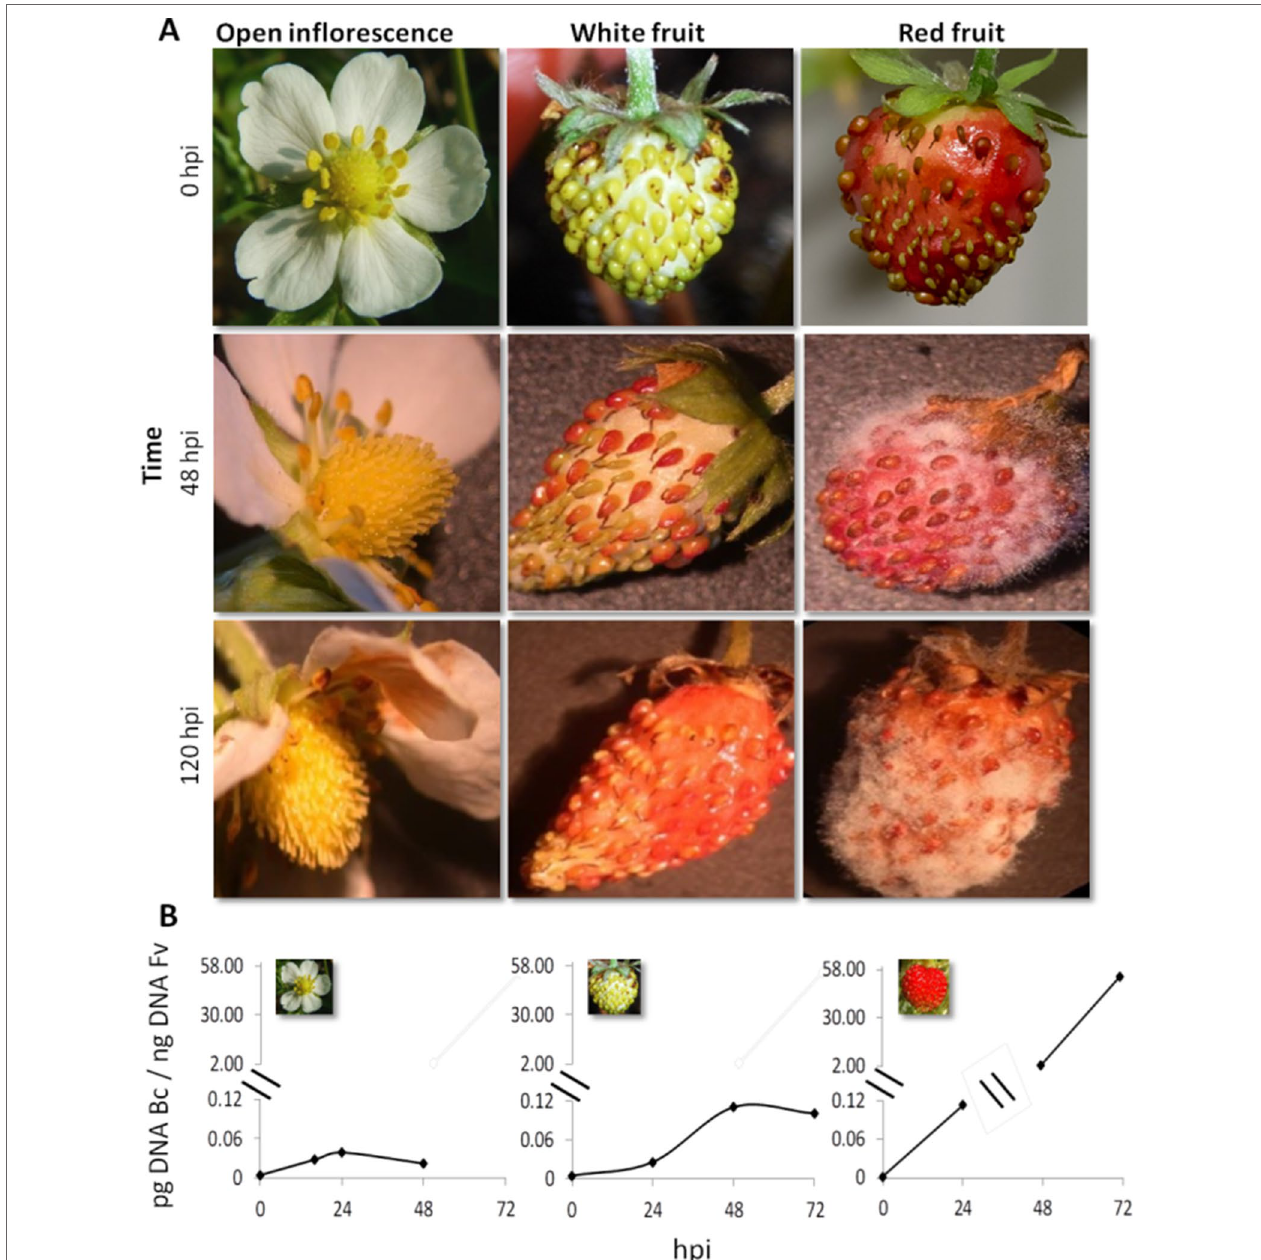
FIGURE 1 | Botrytis cinerea growth on Fragaria vesca flower and fruits. (A) Progress of B. cinerea infection on flower, white fruit, and red fruit up to 120 h postinoculation (hpi). Inoculation was made by dropping 10 μl of 1 × 10 5 ml −1 conidial suspension. (B) Growth kinetics of B. cinerea on flower, white fruit, and red fruit of F. vesca . Bc, B. cinerea ; Fv, F. vesca